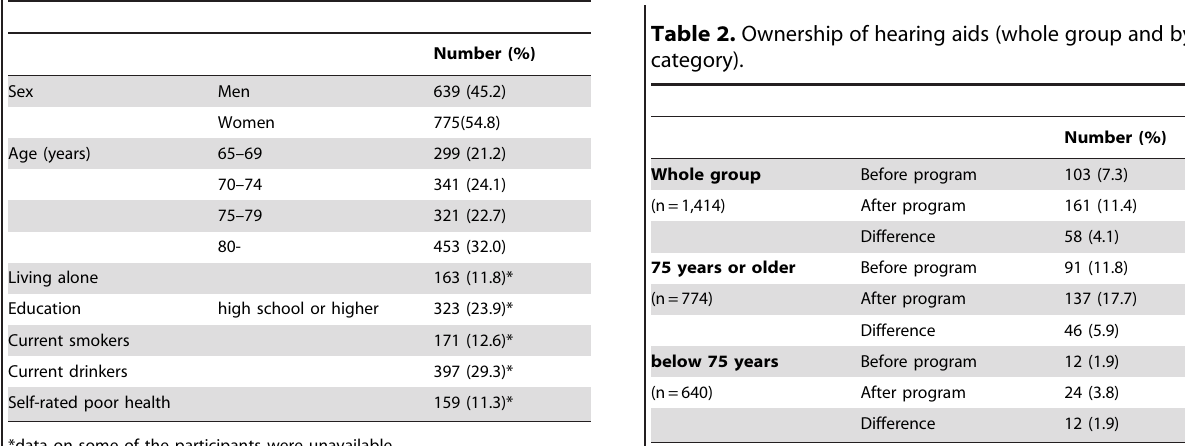
Table 1. Characteristics of the study population (n=1,414).